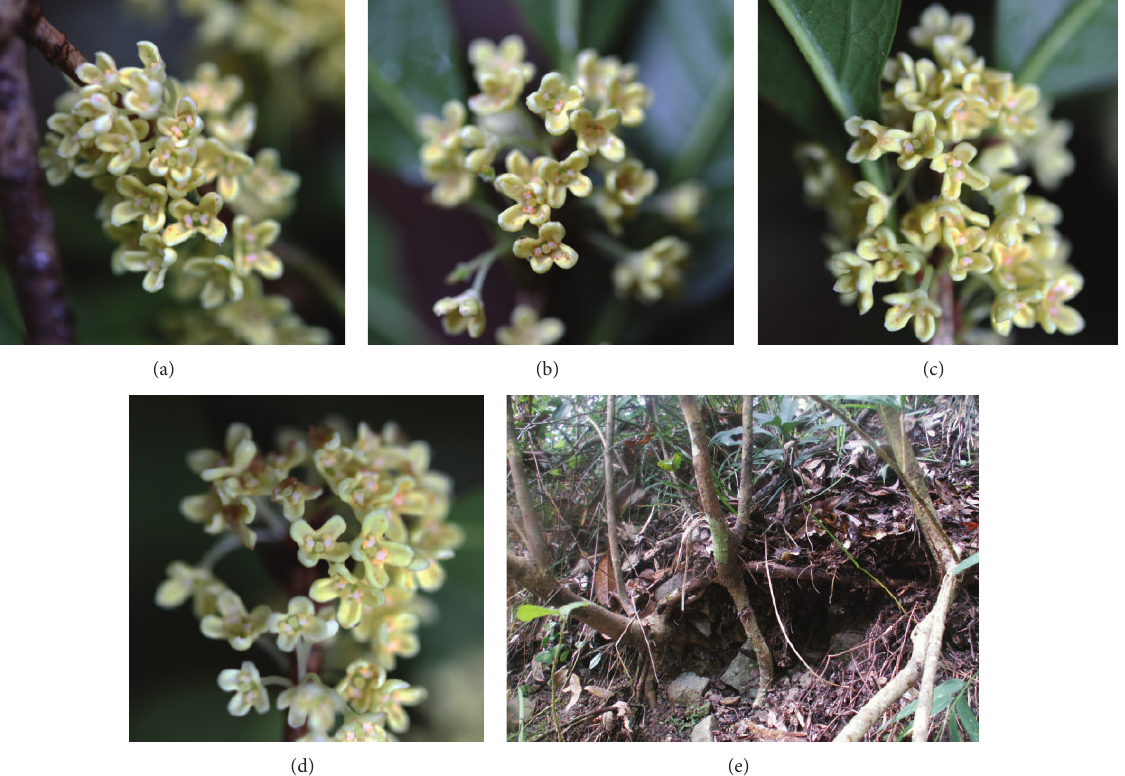
Figure 4: Floral traits of four individuals (a–d) and clone reproduction (e) in LQZGQ